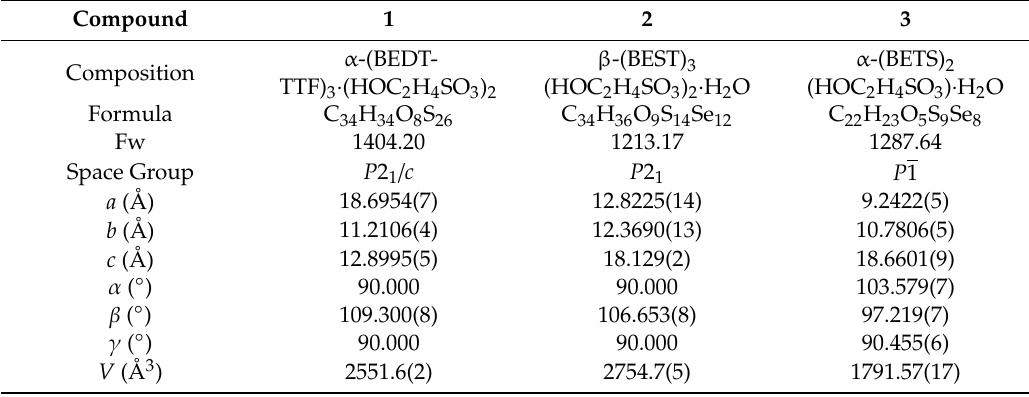
Table 1. Crystallographic data of 1 , 2 and 3 .